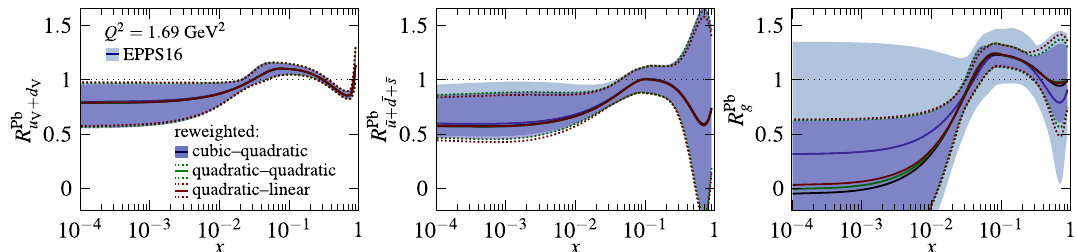
Fig. 13 The impact on the average valence and sea quark and gluon modifications under different approximations in the